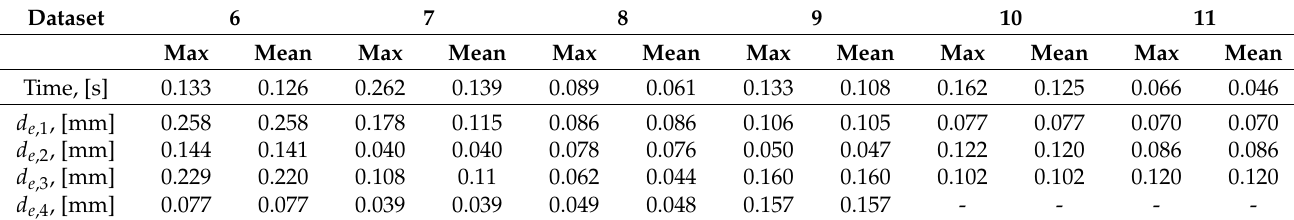
Table 4. Segment fit errors and running times for 10 sequential runs using the datasets 6–11. The fit error definition is given in the beginning of Section